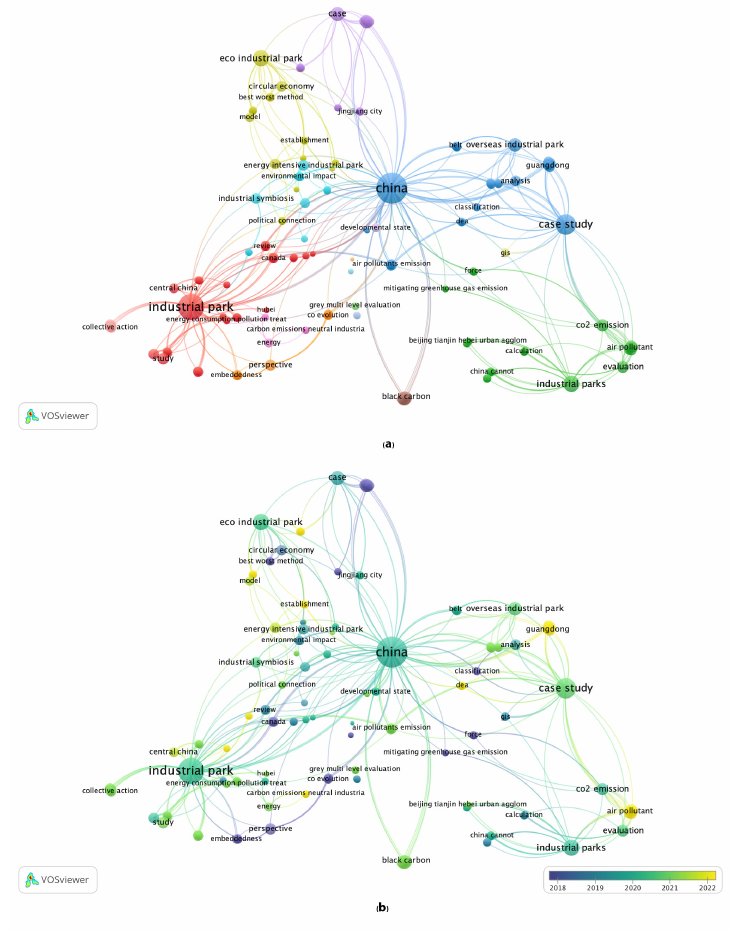
Figure 1. ( a ) Industrial Park development links co-occurrences, “China’s case study”, “circular economy”, and “low carbon emission”. ( b ) network analysis based on major discussion studies from 2010 to 2022 (Source: Web of